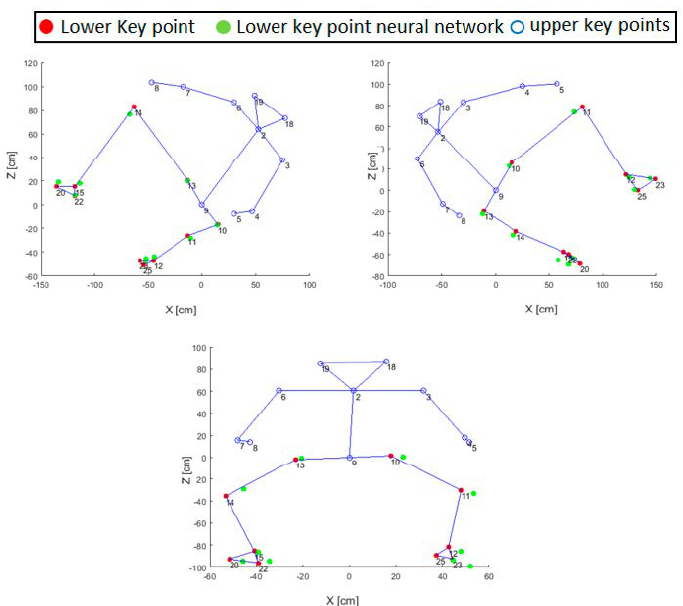
Figure 10. Comparison between estimated and acquired key points in different body configurations. Table 2. Standard deviation value comparison highlighting consistency between the points acquired and processed by means of OpenPose and estimated by means of neural network.